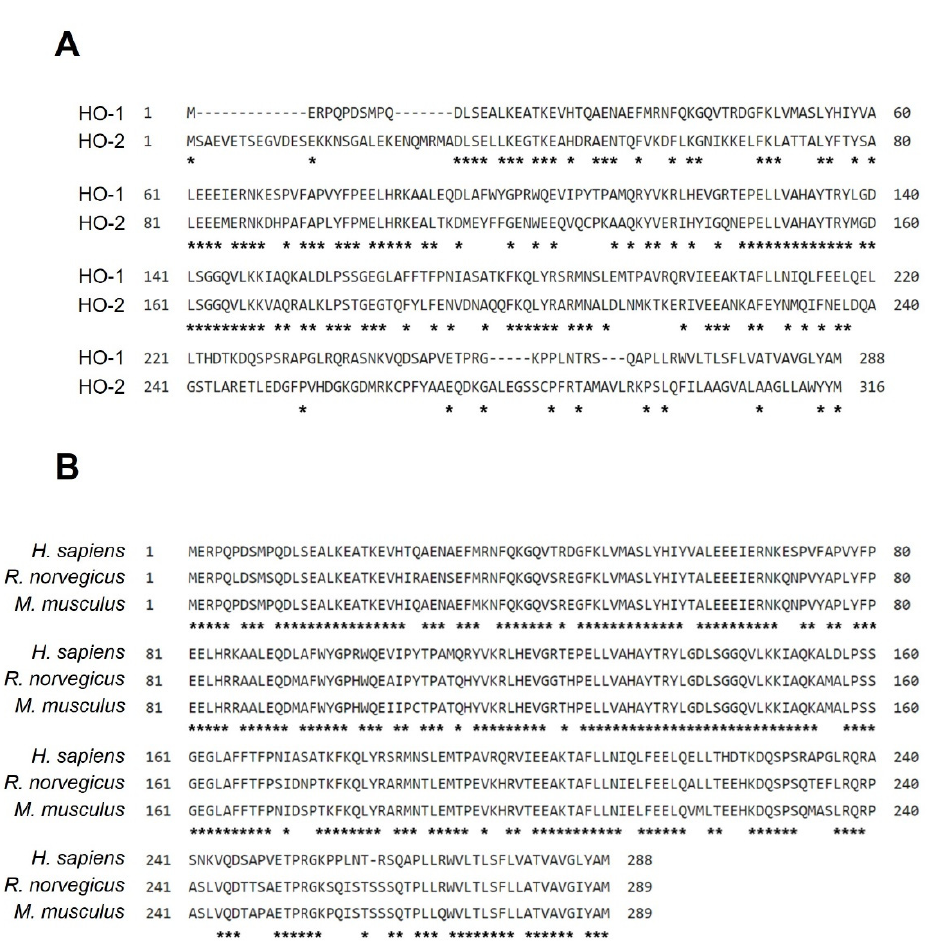
Figure 1. The amino acid alignment of HO. ( A ) Amino acid alignment of HO-1 and HO-2 in human. ( B ) The amino acid homology of HO-1 in humans, rat, and mice. Asterisks indicate common retention regions, meaning that the amino acids here are identical.